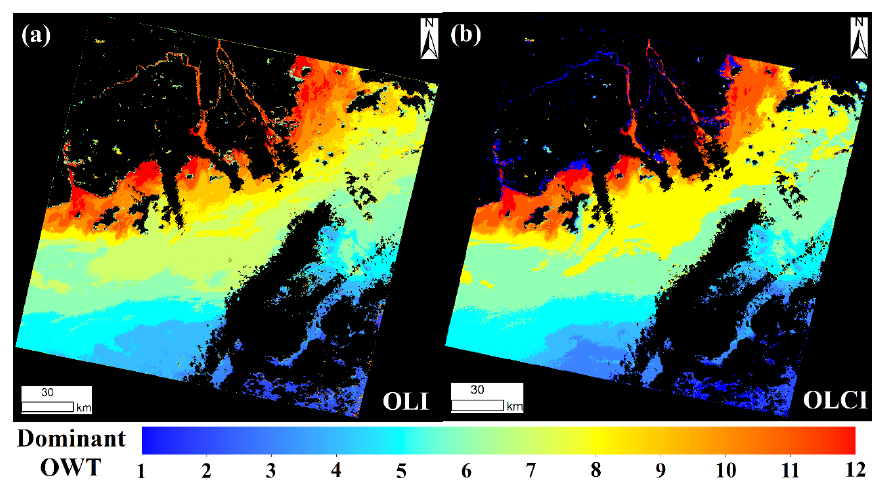
Figure 8. The U-OWT dominant OWT of ( a ) the Pearl River Estuary’s Landsat-8 OLI image on 23 October 2017, and ( b ) the Pearl River Estuary’s Sentinel-3A OLCI image on 23 October 2017. The land and cloud pixels are masked.